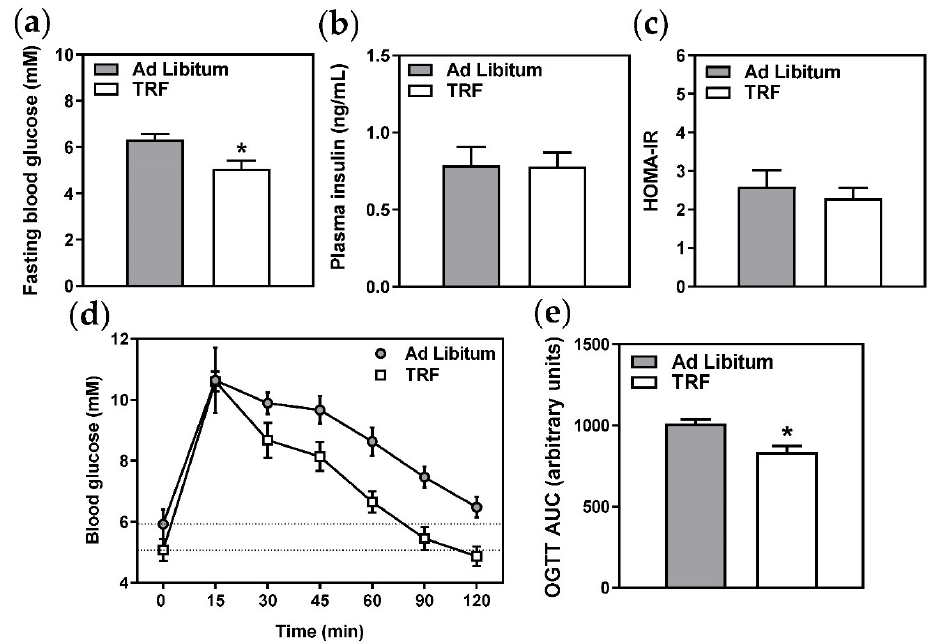
Figure 5. Two-week TRF decreases fasting blood glucose and improves oral glucose tolerance, but does not affect systemic glucose homeostasis. ( a ) Fasting blood glucose was measured immediately prior to sacrifice by handheld glucometer. ( b ) Plasma insulin was measured by ELISA. ( c ) HOMA-IR was calculated using blood glucose and plasma insulin values. ( d ) Glucose tolerance after oral gavage of 1 g glucose / kg body weight was measured following a 6 h fast for the ad libitum group and an approximately 22 h fast for the TRF group on the day prior to sacrifice (day 14). ( e ) Areas under the curve were calculated from data in ( d ). Data are means ± SEM, n = 8–10, * p < 0.05.